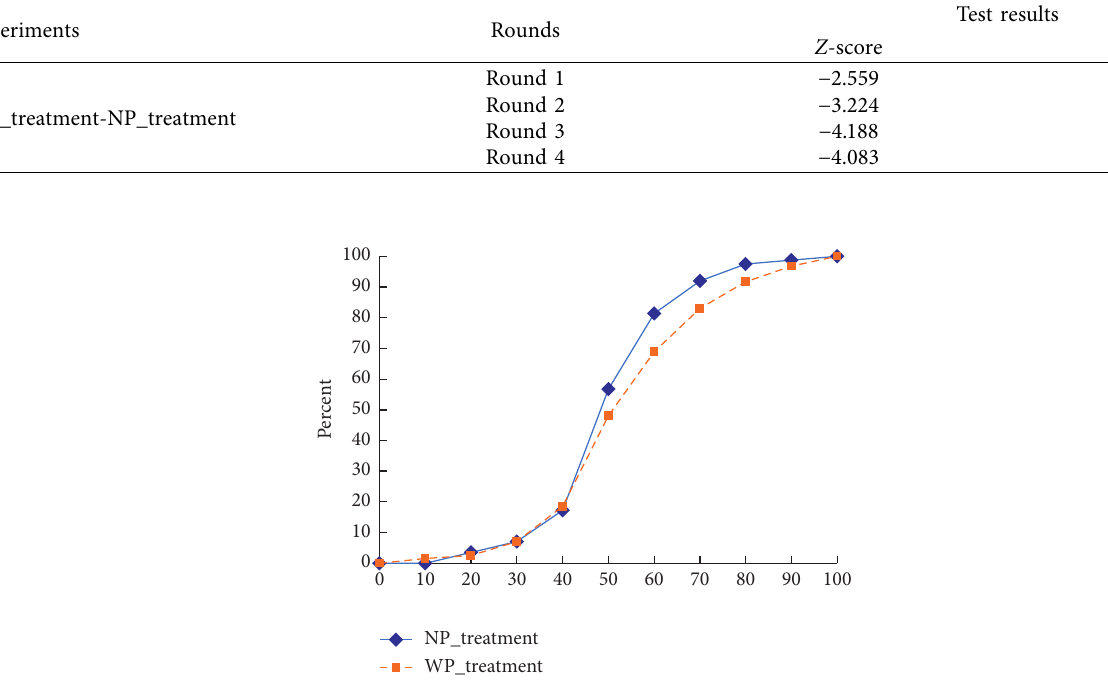
Figure 1: Comparison of cumulative resource investment amounts between the two experiments.